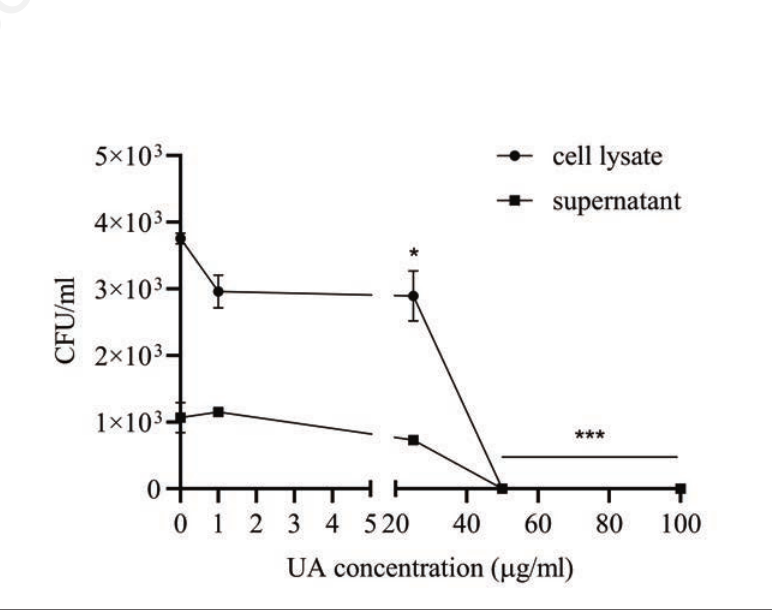
Figure 2. Colony-forming units (CFU) of Mycobacterium avium in model 2. The results are described as mean of ± SD, with each experiment performed in triplicate;